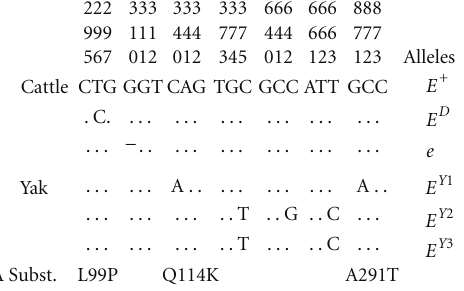
Figure 3: Network profile of the yak and cattle MC1R haplotypes. The links are labeled by nucleotide positions to designate transition; transversions are further specified in bold. The MC1R haplotype frequency in yak was proportional to the circle area. Yaks with white coat color and black coat color were marked by white and black, respectively. The three cattle alleles ( E + , E D , and e ) were denoted by dots. The predicted coding region of the yak MC1R